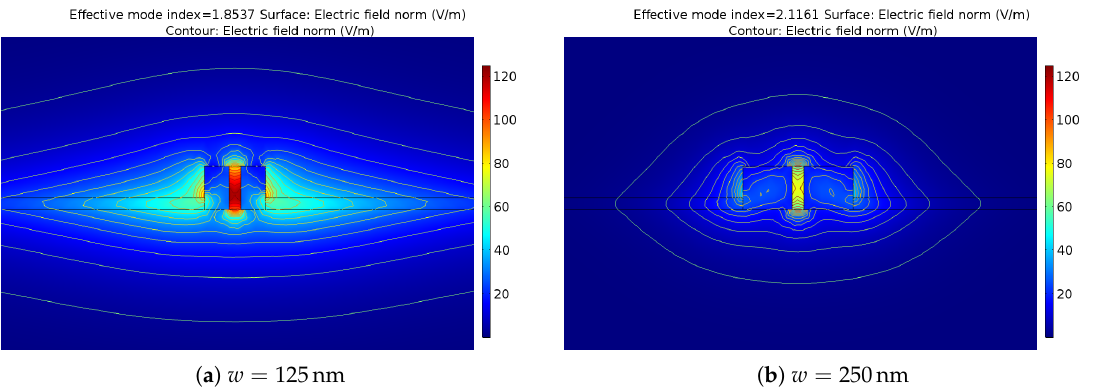
Figure 9. Effect of the waveguide width w on the modal properties. A higher confinement can be found for larger w .